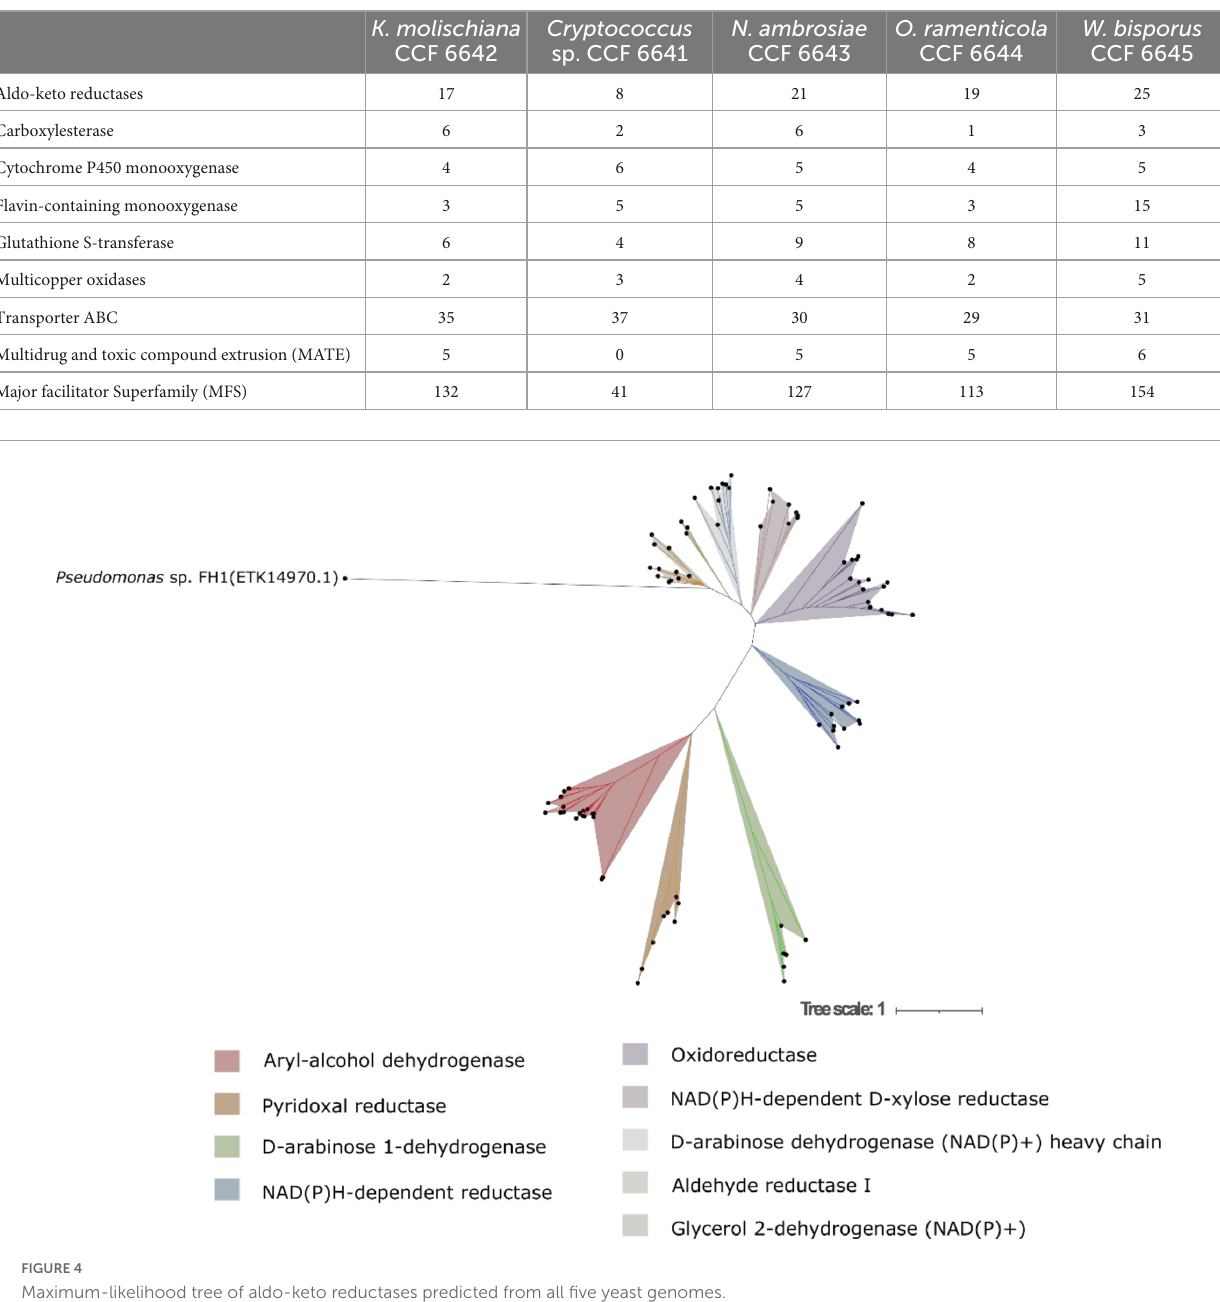
TABLE 3 Number of genes involved in the detoxification process.